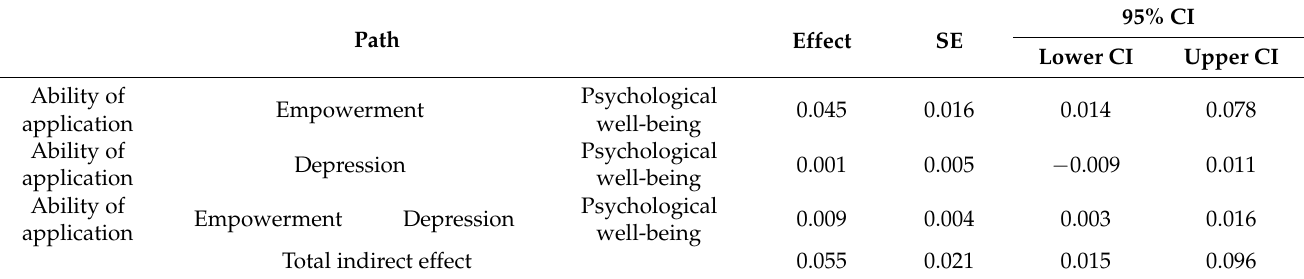
Table 5. Verification of indirect effect of empowerment and